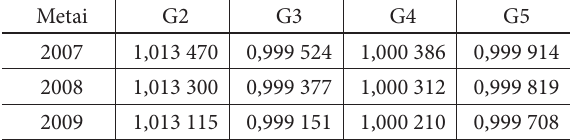
Table 1 . The calibration coefficients of the gravimeters Metai G2 G3 G4 G5 2007 1,013 470 0,999 524 1,000 386 0,999 914